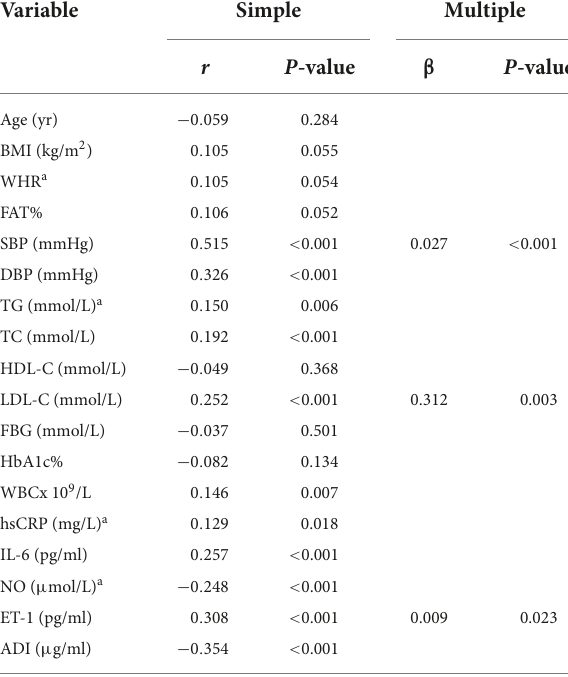
TABLE 2 Linear regression analysis of variables associated with circulating sortilin levels in the study population. Variable Simple